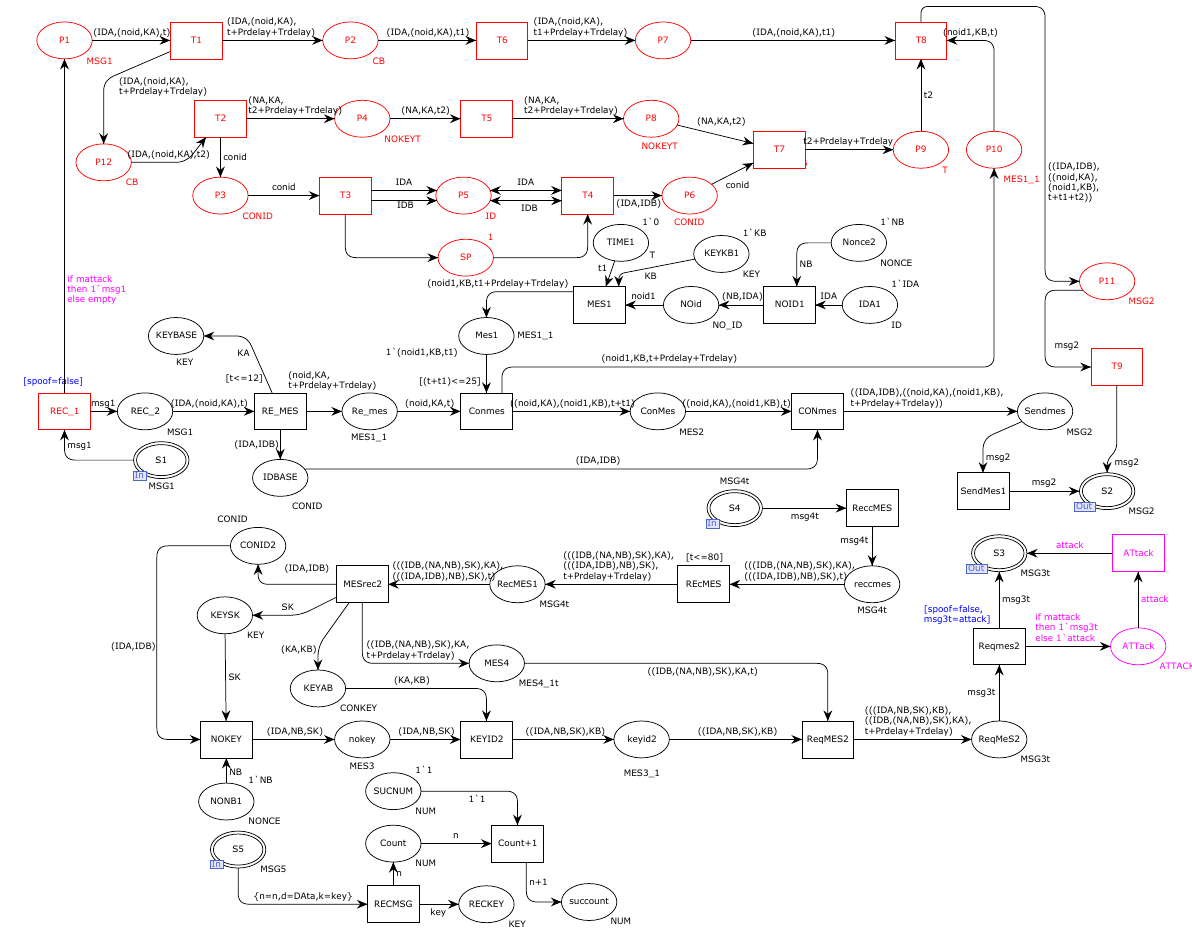
Figure 13. Improvement scheme to include the attacker model. Table 4. State space comparison of three attack